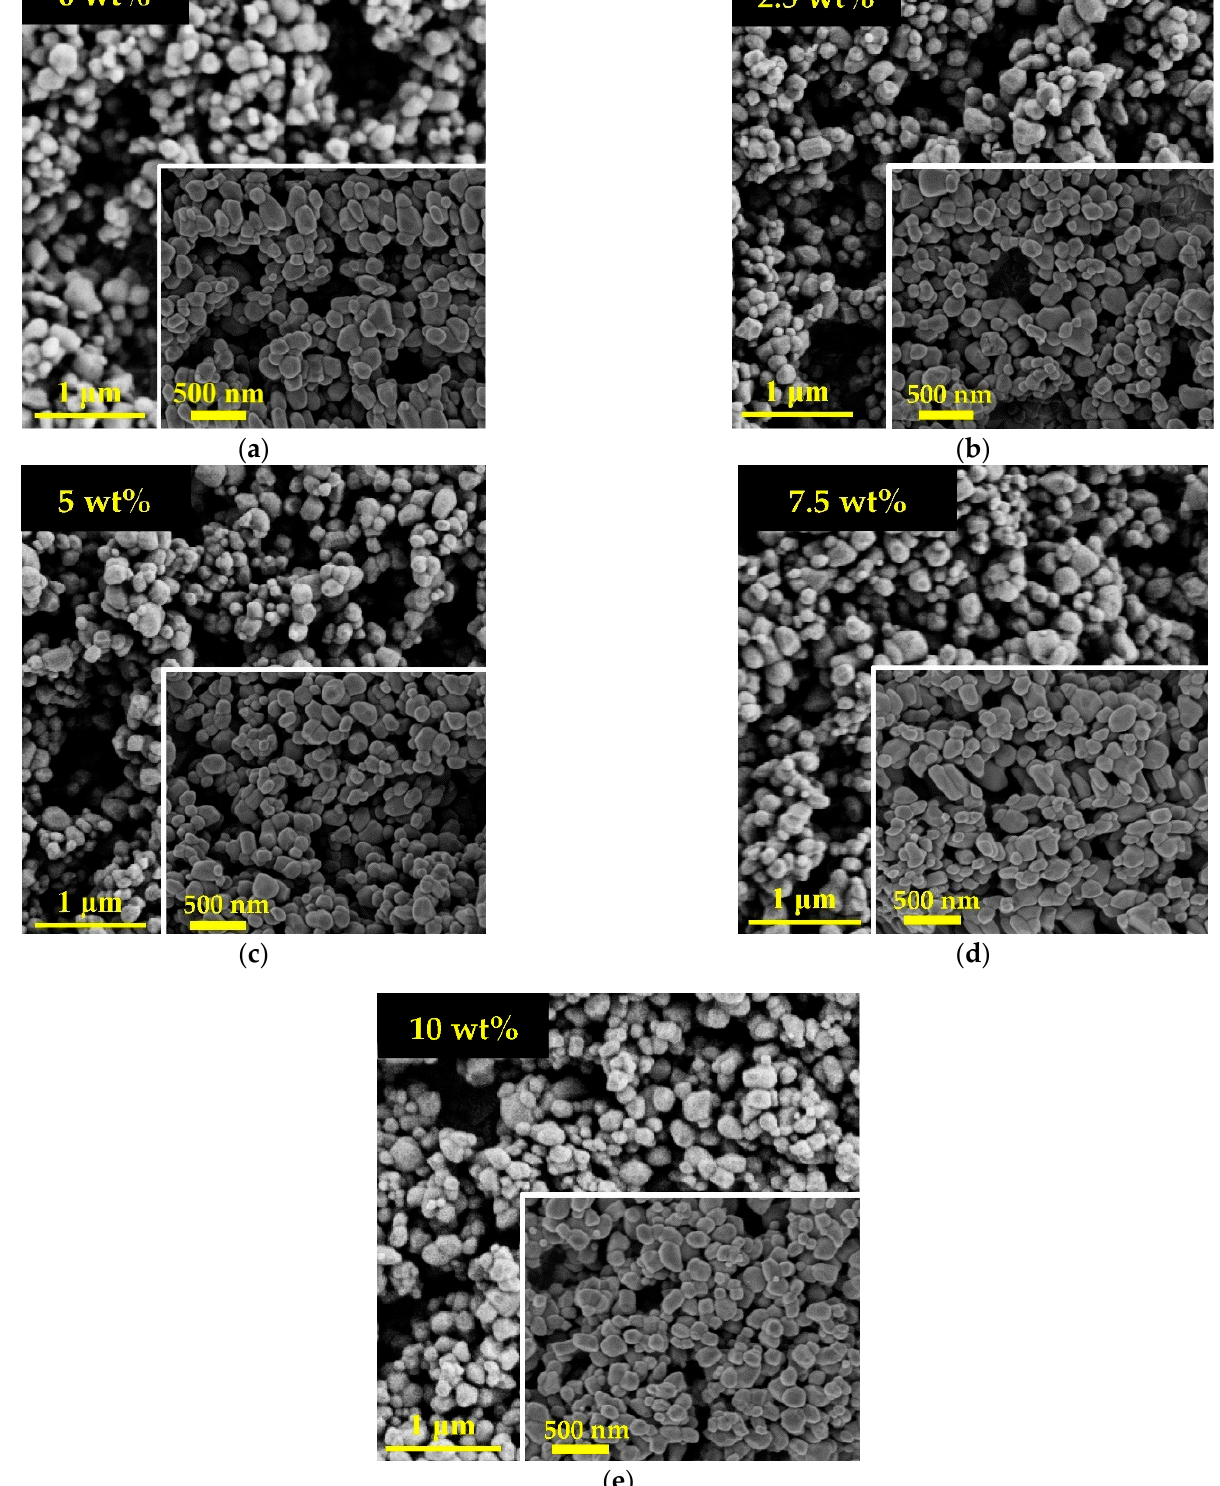
Figure 7. The cross-sectional SEM images of the 350 °C-annealed TiO 2 film prepared by injecting different DMF doses of ( a ) 0, ( b ) 2.5, ( c ) 5, ( d ) 7.5, and ( e ) 10